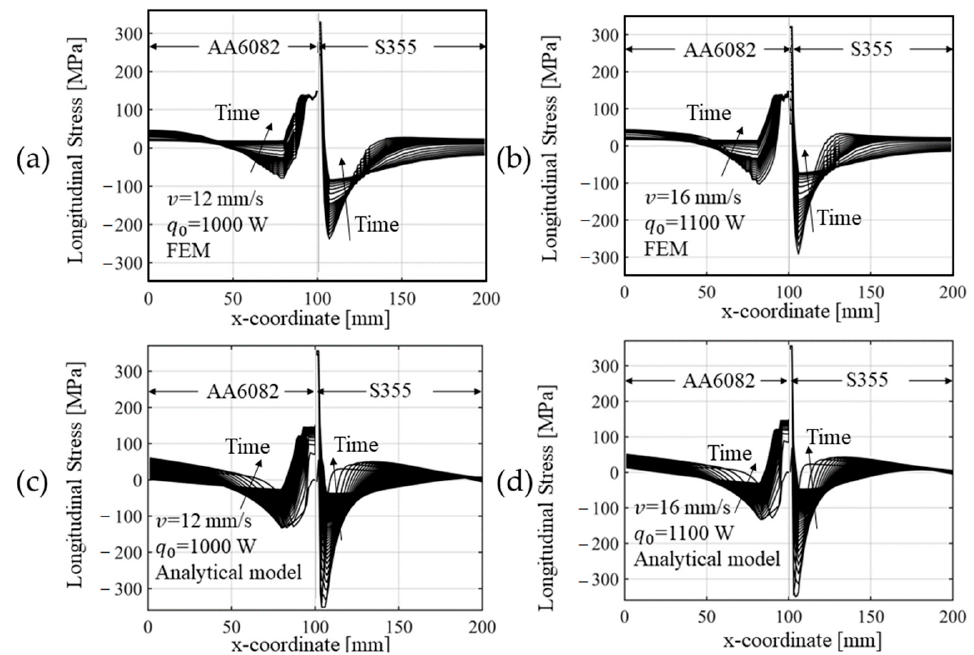
Figure 12. Longitudinal ( y direction) stress at different time steps for the welding speed of ( a , c ) 12 mm/s and ( b , d ) 16 mm/s and power input of ( a , c ) 1000 W and ( b , d ) 1100 W, respectively, calculated via ( a , b ) FE model and ( c , d ) via rapid analytical method. Values of stress refer to the mid-thickness of a cross section taken orthogonal to the welding direction in the middle length of the plates.